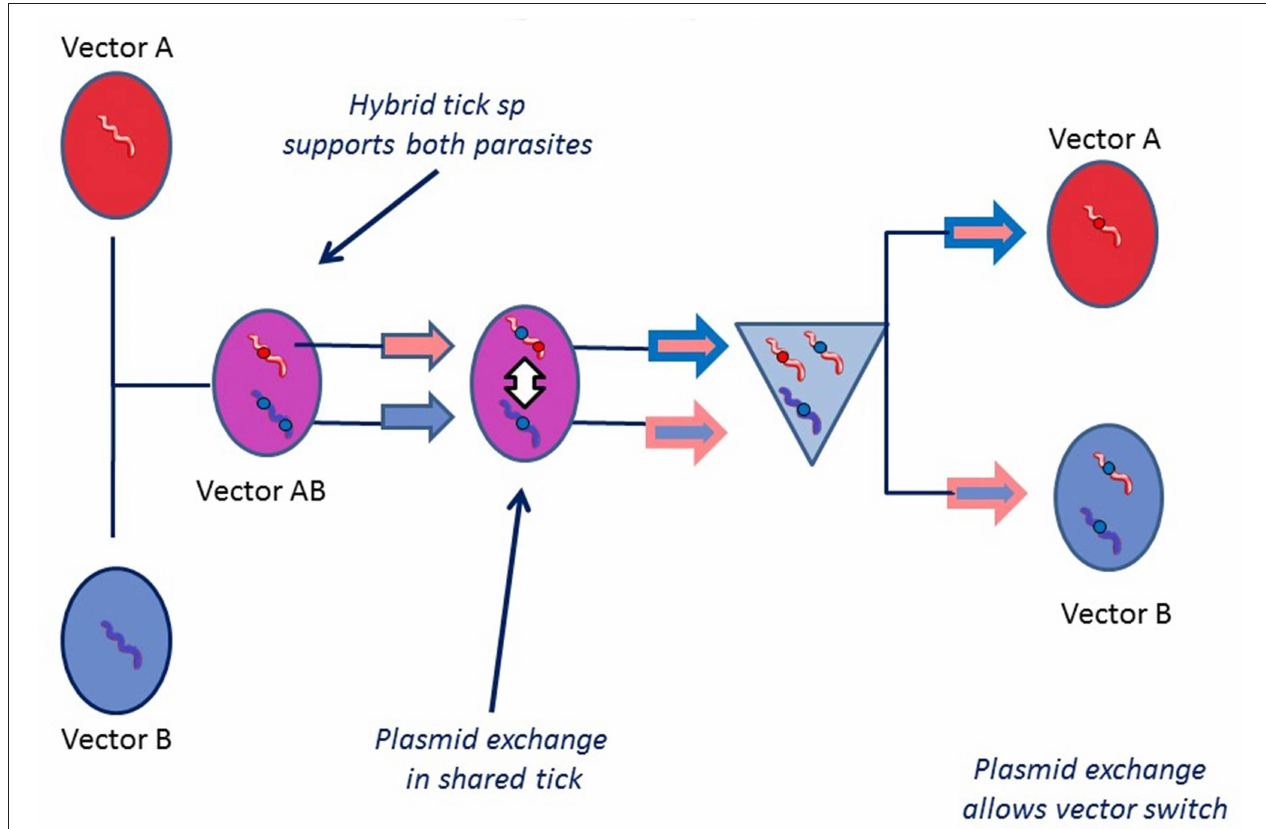
FIGURE 7 | Plasmid exchange vector adaptation hypothesis. This hypothesis supposes that bacterial plasmid exchange may take place inside a vector tick that harbors two different Borrelia species. It may be particularly easy for a Borrelia to adapt to a new environment in a hybrid tick because it will express midgut receptor or immune related proteins from both parents. For plasmid exchange to happen, it is necessary for both species to be present in the same place and at the same time. Even if one of the species is killed (if the tick feeds on a non-permissive host for one of the species), plasmid transfer may still happen. If an Asian strain of B. bavariensis (normally dependent on I. persulcatus as a vector) acquired one or more plasmids from a species of spirochete, for example B. afzelii , that enabled it to colonize the European tick I. ricinus , then the vector switch would be achieved.